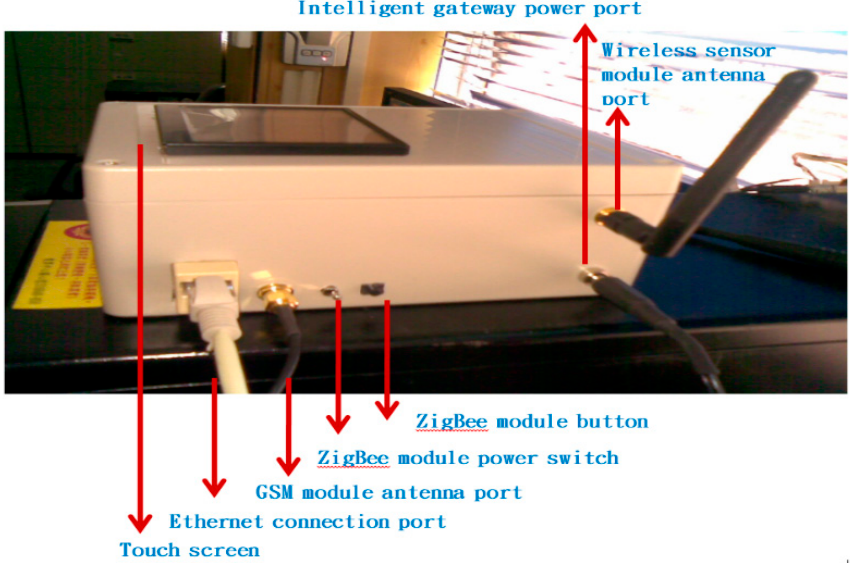
Figure 12. Exterior of the smart gateway.